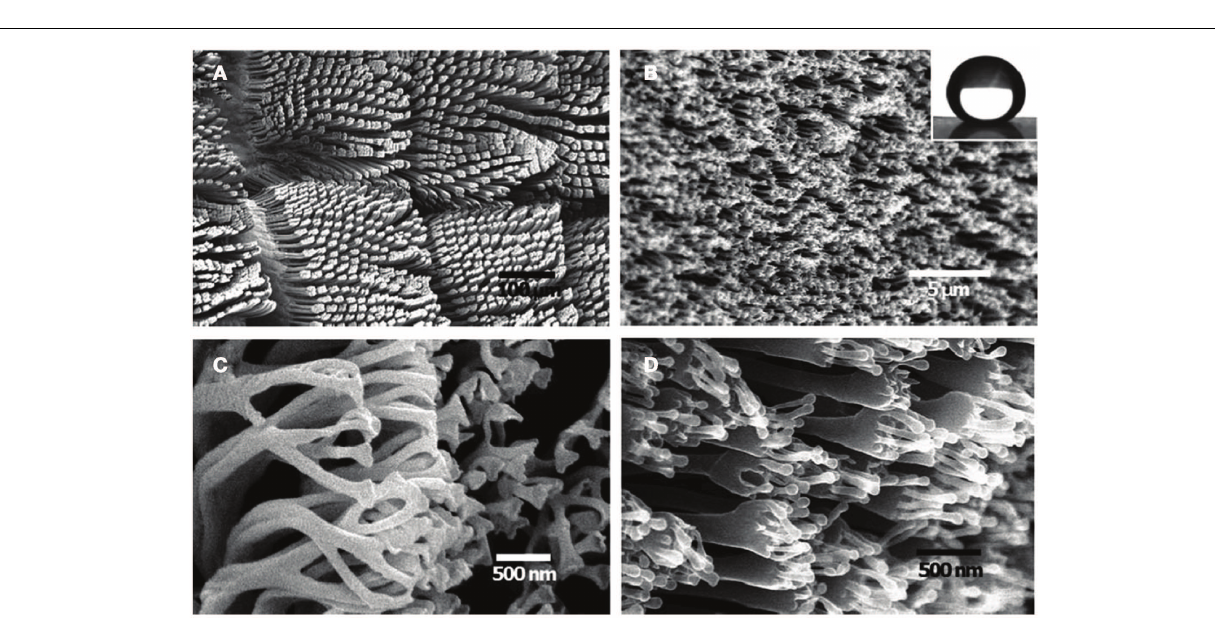
FIGURE 2 | SEM images of aTokay Gecko (Gekko gecko) (A,C) and fabricated hierarchical polystyrene (PS) nanohairs with high aspect ratio (AR) (B,D) . Inset in (B) water contact angle of the elongated hierarchical PS nanohairs. From Lee et al.